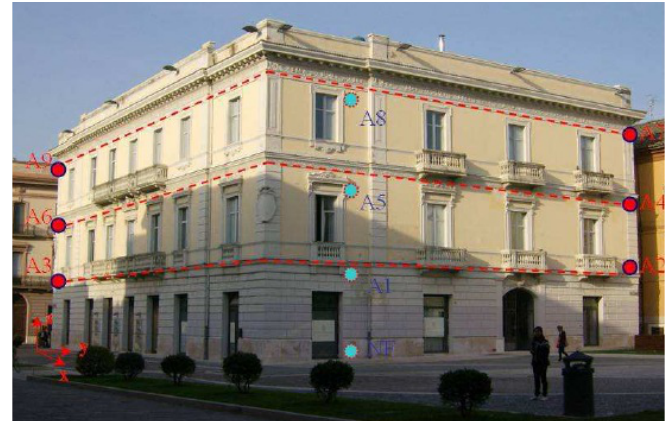
Figure 5. Position of accelerometers in the building.